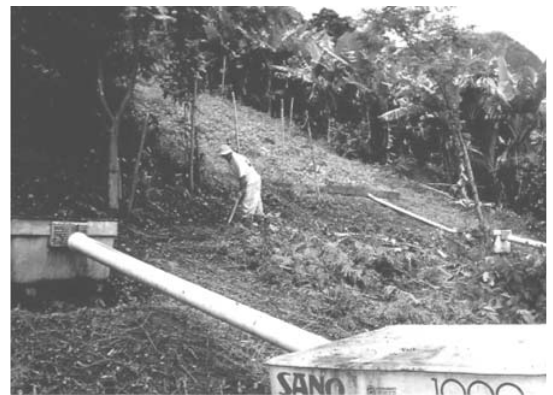
Figura 1. Vista das parcelas na encosta sob diferentes formas de cultivo e pousio